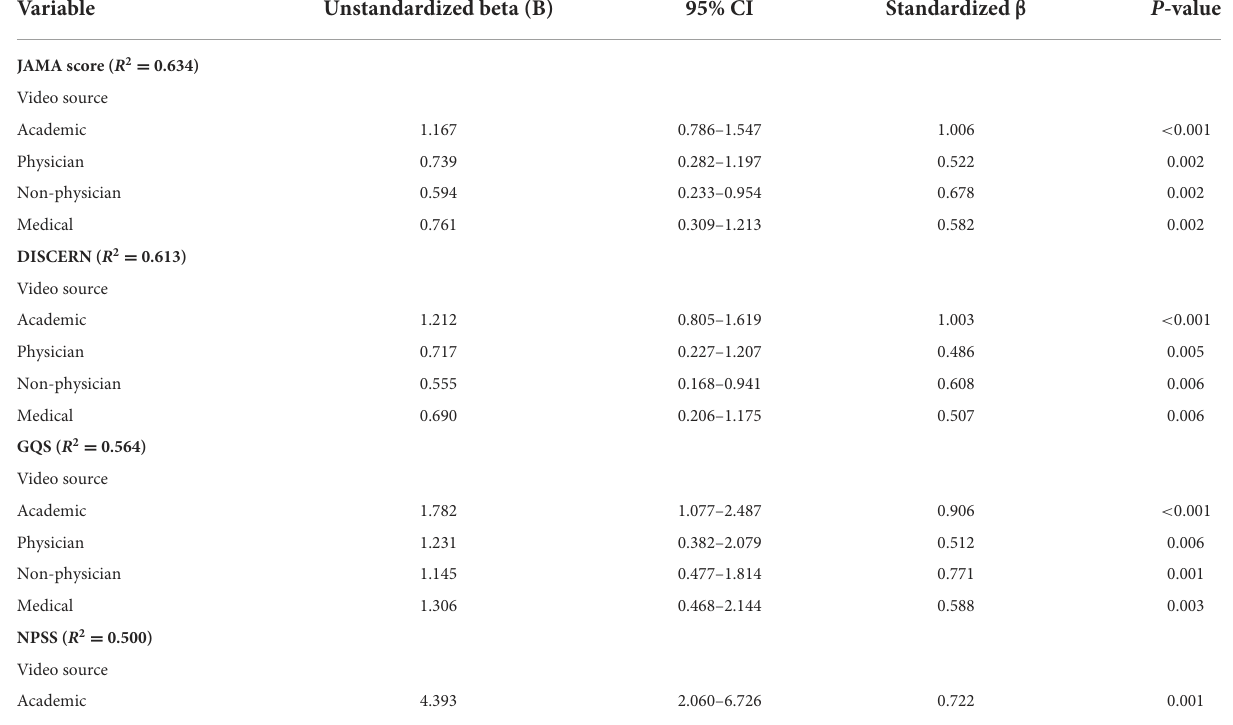
TABLE 7 Multiple linear regression analysis of correlations between video characteristics and the JAMA score, DISCERN, GQS, and NPSS.